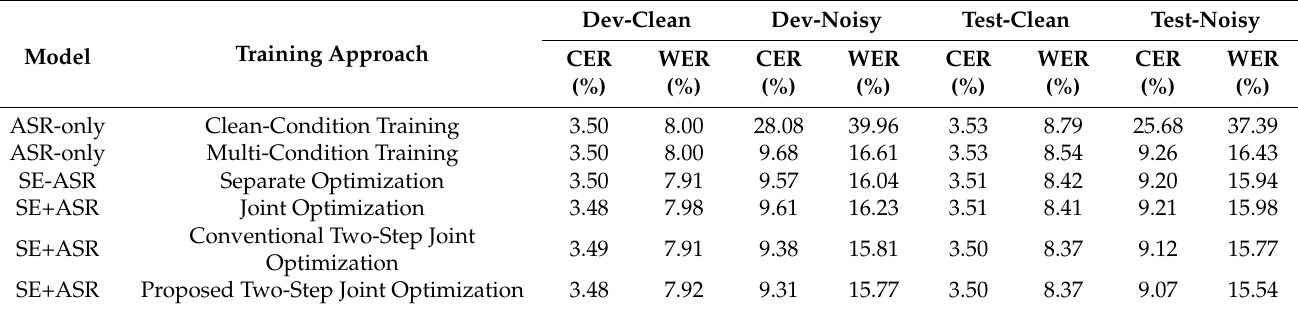
Table 1. Comparison of the average character error rate (CER) and word error rate (WER) of automatic speech recognition (ASR) models trained by various optimization approaches under clean and matched noise